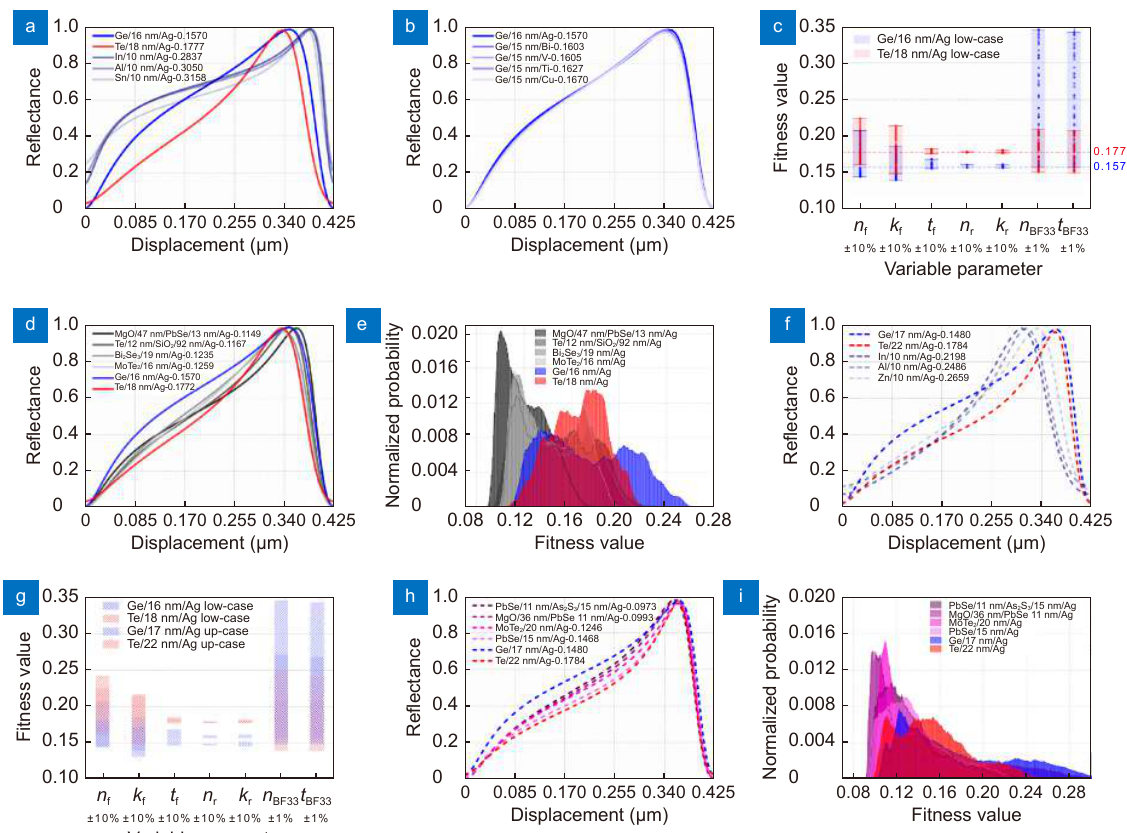
Fig. 5 | Optimization results of the sawtooth-like design. ( a ) Light-displacement responses of 5 primary candidates of the single-layer setting among the simple substance materials for the low-case. ( b ) Light-displacement responses of the candidates with Ge but different moving mirror materials for the single-layer low-case setting. ( c ) Single-parameter tolerance analysis results of single-layer low-case settings of Ge and Te, where the circles represent the calculated fitness value for each random variable parameter, the chain dotted lines represent the original fitness values, and the blocks represent the variation range of the fitness values. ( d ) Light-displacement responses of primary candidates of both two- layers and single-layer settings among the whole materials for the low-case. ( e ) Histogram of multi-parameter tolerance analysis results of all candidates for the low-case. ( f ) Light-displacement responses of 5 primary candidates of the single-layer setting among the simple substance materials for the up-case. ( g ) Comparison of single-parameter tolerance analysis results of Ge and Te for both low- and up-cases, where blue and red colors represent the Ge and Te results, and left and right slashes represent low- and up-cases, respectively. ( h ) Light-displacement re- sponses of primary candidates of both two-layers and single-layer settings among the whole materials for the up-case. ( i ) Histogram of multi- parameter tolerance analysis results of all candidates for the